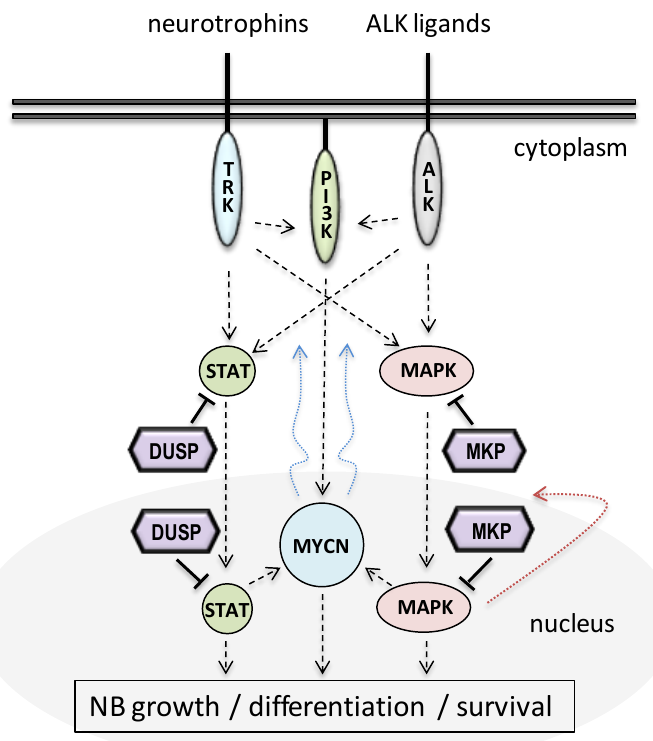
Figure 1. Schematic depiction of the major pathways involved in signaling through the ALK-MYCN axis in neuroblastoma (NB). ALK signals downstream mainly through the RAS-ERK1/2 MAP kinase (MAPK) pathway, as well as through the PI3K/AKT and JAK/STAT pathways, resulting in increased MYCN transcription and cell growth (straight dashed lines). Signaling through Trk neurotrophin receptors is also shown. MYCN transcriptional activity positively feeds the pathway by promoting ALK transcription (curved blue dotted lines), whereas transcriptional activity mediated by the MAPK nuclear effectors negatively feed-back the MAPK pathways by promoting the transcription of MAPK phosphatases (MKP) genes (curved red dotted line). Straight solid lines indicate direct dephosphorylation of protein substrates by MKPs or by other dual-specificity phosphatases (DUSPs). Dephosphorylation of MAPKs by MKPs is well documented, whereas evidence on the dephosphorylation of STATs or Trks by other DUSPs is limited. See text for more details.